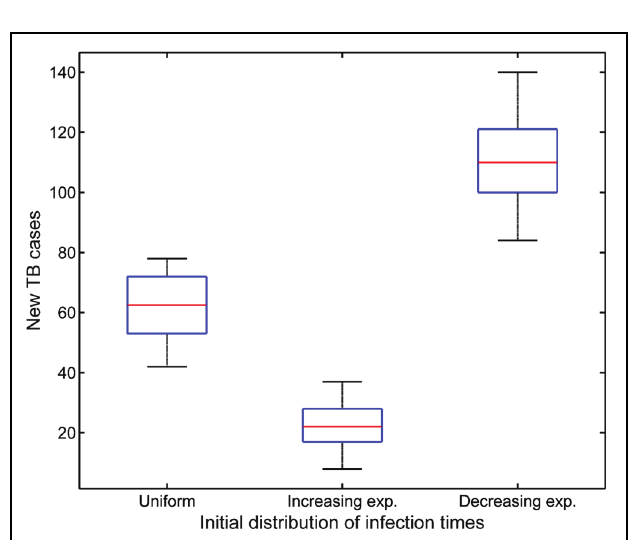
FIGURE 6 | Boxplots of virtual experiments results, showing the effect of the distribution of initial infection times (Figure 5) on the number of new TB cases after one simulated